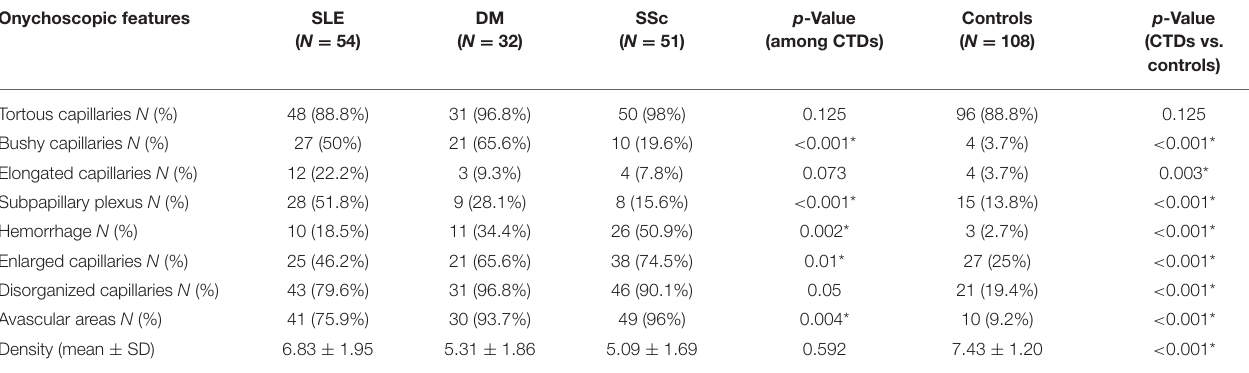
TABLE 2 | Comparison of onychoscopic features between connective tissue diseases and healthy controls. Onychoscopic features